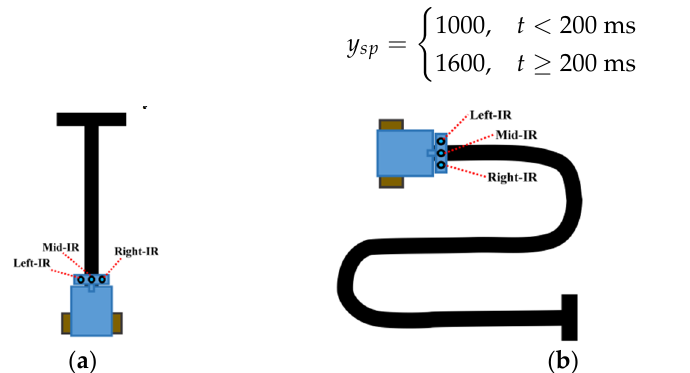
Figure 11. Robot control system test site. ( a ) Straight line site for step response test, ( b ) S-curve tracking path.